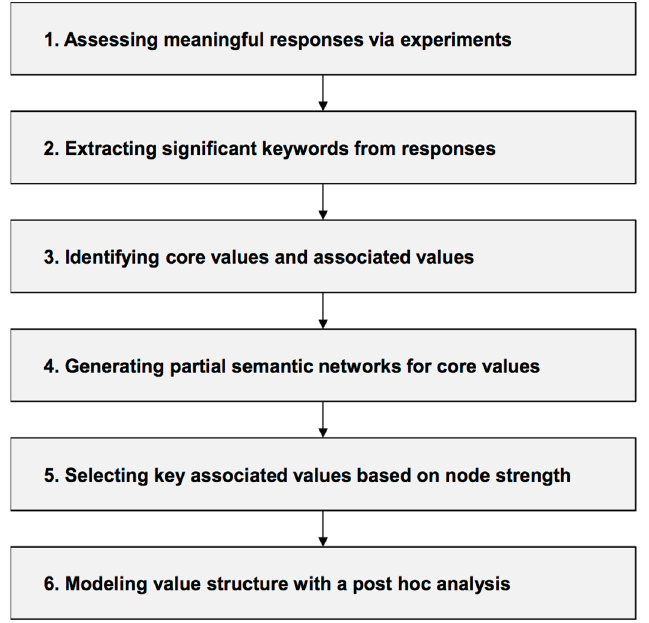
Figure 2. Value structuring process in this study.